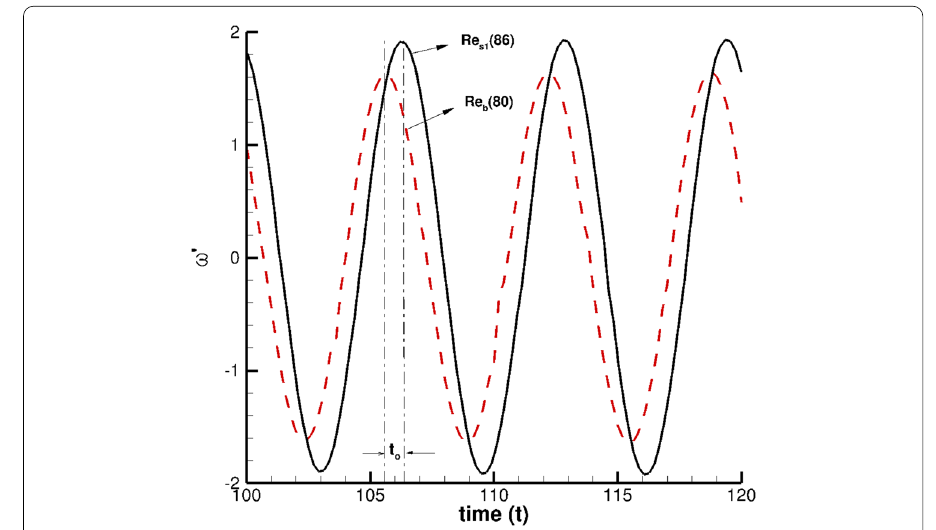
Fig. 4 Variation of disturbance vorticity at a point (0.504, 0.0) with t b and t s for Re b and Re s , respectively, for the pair of Re b = 80 and Re s = 86 in the bifurcation sequence 78 ≤ Re ≤